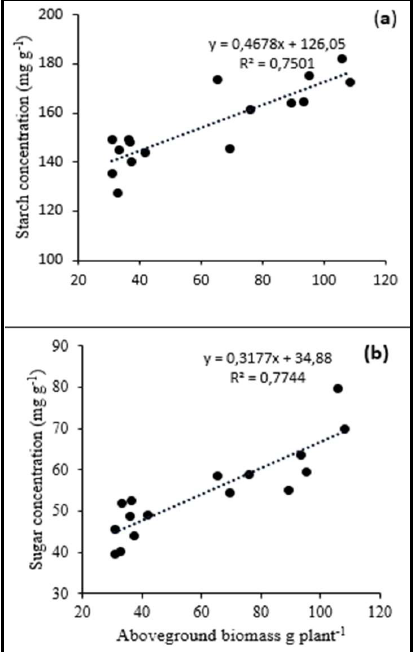
Figure 1. Relationship between aboveground biomass and ( a ) starch and ( b ) sugar concentration in roots of S. sesban roots subjected to three pruning frequencies.